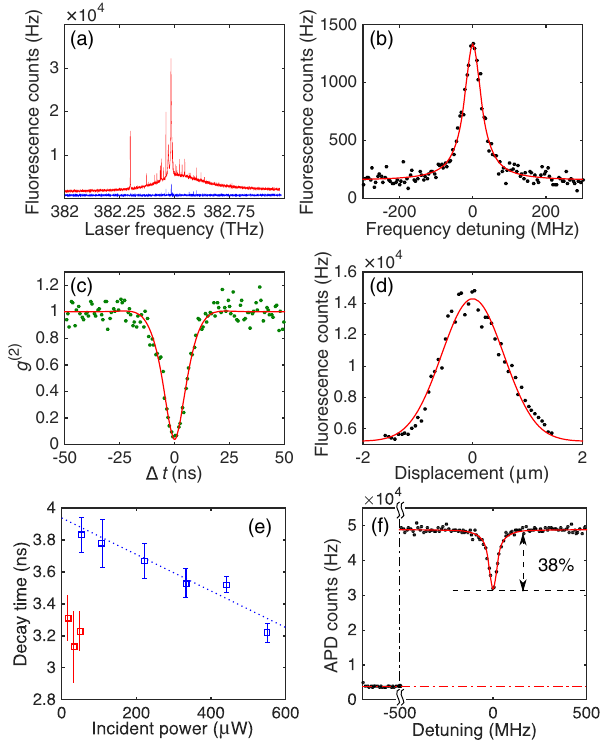
FIG. 3. (a) The red and blue spectra show the detected Stokes- shifted fluorescence for λ > 785 nm when an incident laser is scanned across the inhomogeneous broadening of the molecules for the cases of cavity locked on resonance and micromirror retracted, respectively. The width of the red envelope gives a measure for the cavity FWHM of 250 GHz. The sharp resonances represent molecules coupled to the cavity. (b) A zoom of one sharp resonance as recorded in (a) with a Lorentzian fit. (c) g ð 2 Þ measured via a coincidence Hanbury Brown – Twiss (HBT) study. (d) A lateral cross section of the cavity mode in the AC crystal mapped by measuring the fluorescence of a single molecule. The solid curve shows a Gaussian fit. (e) The red symbols show the decay time of the molecular excited state extracted from HBT measurements in a resonant cavity at low power. The blue symbols display the HBT decay time recorded in the absence of the curved mirror at different incident powers measured before the cryostat. Extrapolation of a linear fit gives the lifetime in the limit of zero excitation intensity. (f) Transmission of the resonant cavity-molecule system as a function of laser frequency detuning. The left-hand side shows the signal for the laser frequency far from the cavity